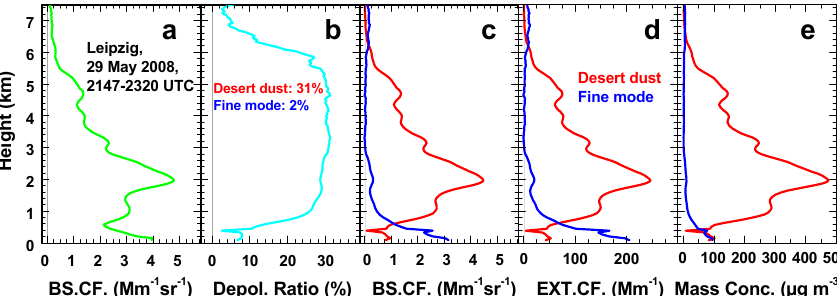
Fig. 2. (a) 532nm particle backscatter coefficient, (b) 532nm particle linear depolarization ratio, (c) fine–mode (blue) and coarse-mode (red) particle backscatter coefficients, (d) fine-mode (blue) and coarse-mode (red) particle extinction coefficients, (e) and fine-mode (blue) and coarse-mode (red) particle mass concentrations. The lidar observations were taken at Leipzig (120m above sea level, a.s.l.) in May